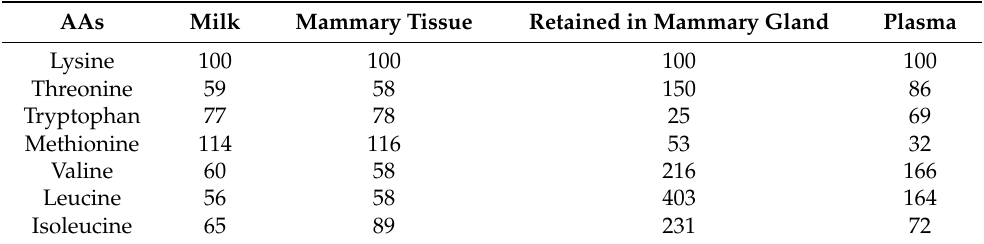
Table 4. Pattern of the different AAs ratios to lysine for different pools in lactating sows (adapted from different sources